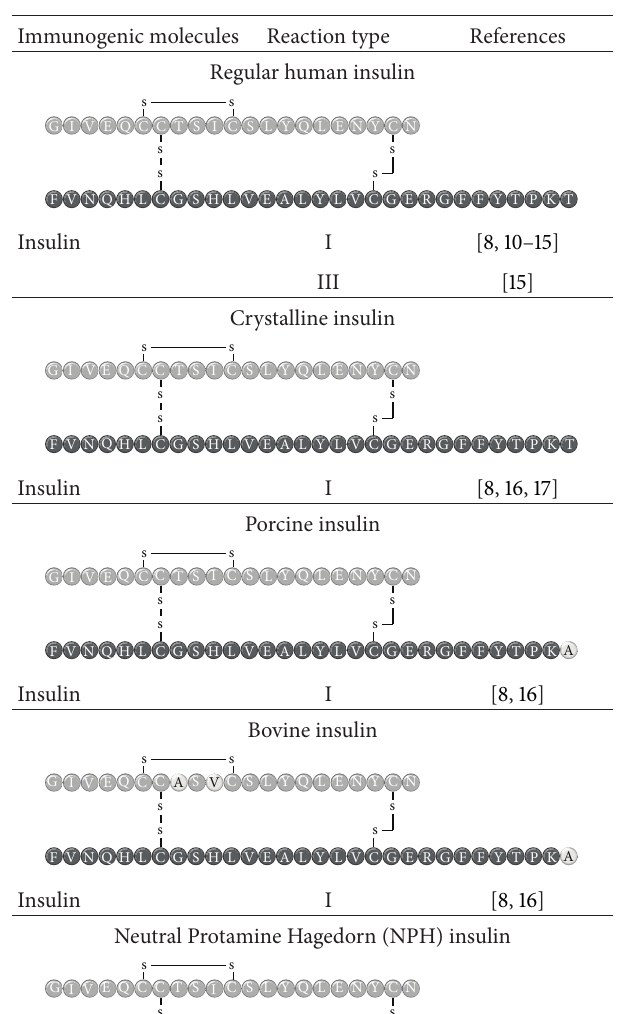
Table 1: Insulin analogues and recombinant variations, structure, and related immunogenic reactions.